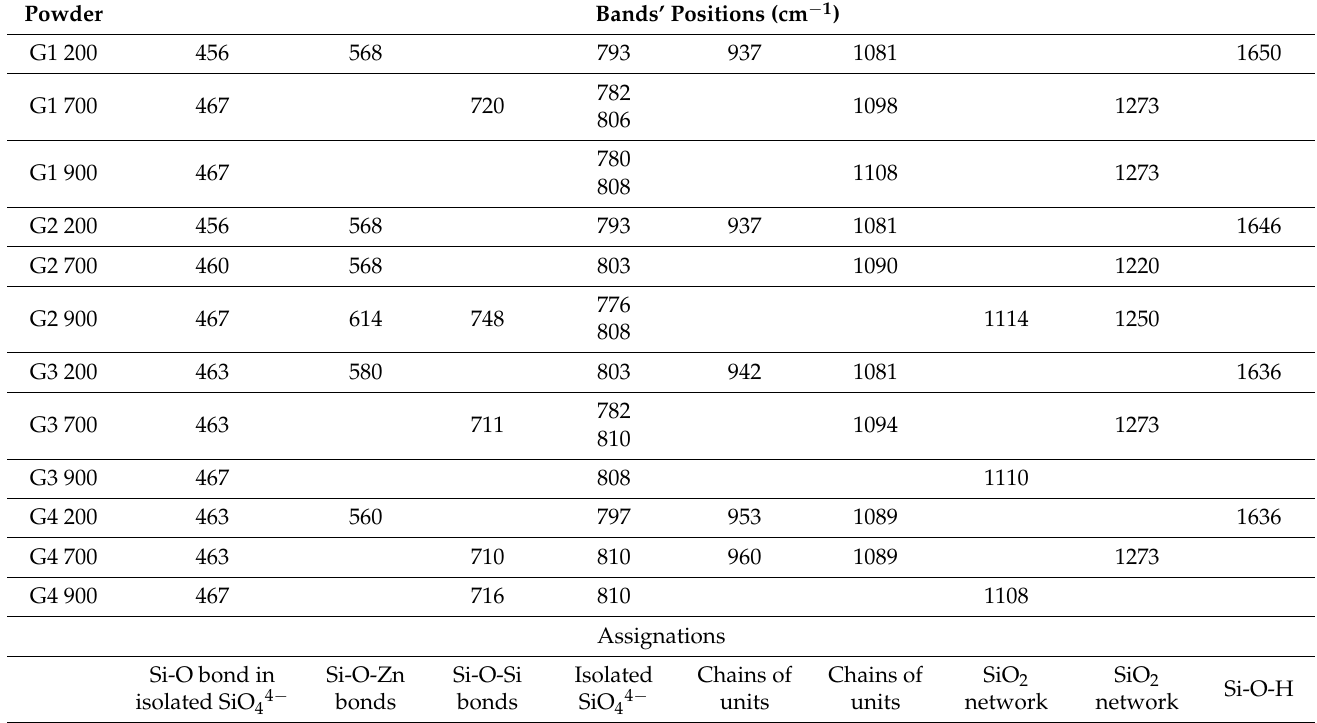
Table 1. Main bands in FTIR spectra of all